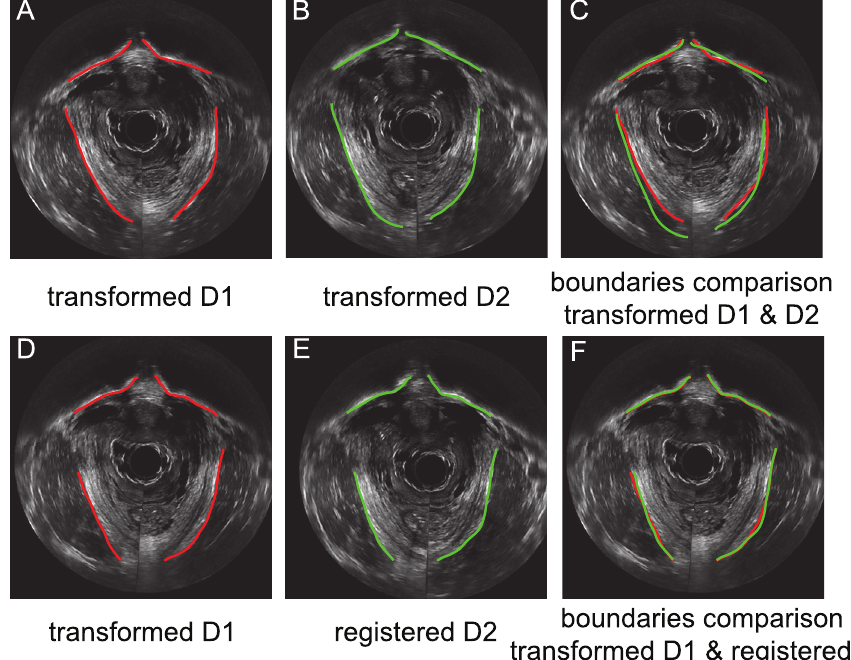
Fig 6. Pubic bone and muscle volumetric registration and validation after each stage. Before stage 2 registration, pubic bone and levator ani muscle boundaries are manually outlined in transformed D1 (A) and transformed D2 (B). The pubic bone boundaries show satisfying spatial proximity but the muscles misaligned (C). After stage 2 (D) and (E), bone and muscles boundaries were effectively aligned (F).